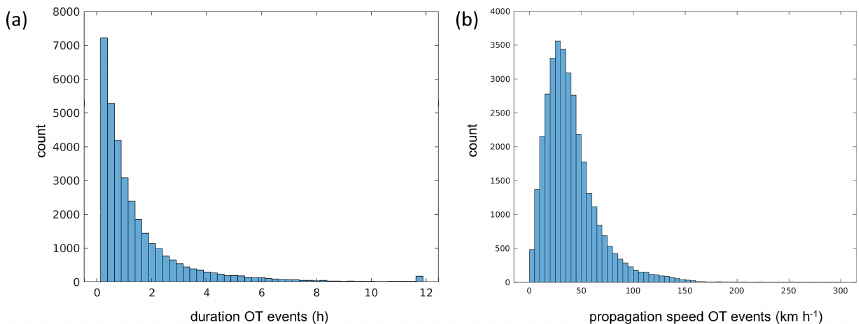
Figure 7. Histogram of hail-filtered OT event (a) duration and (b) propagation speed, 2005–2018.